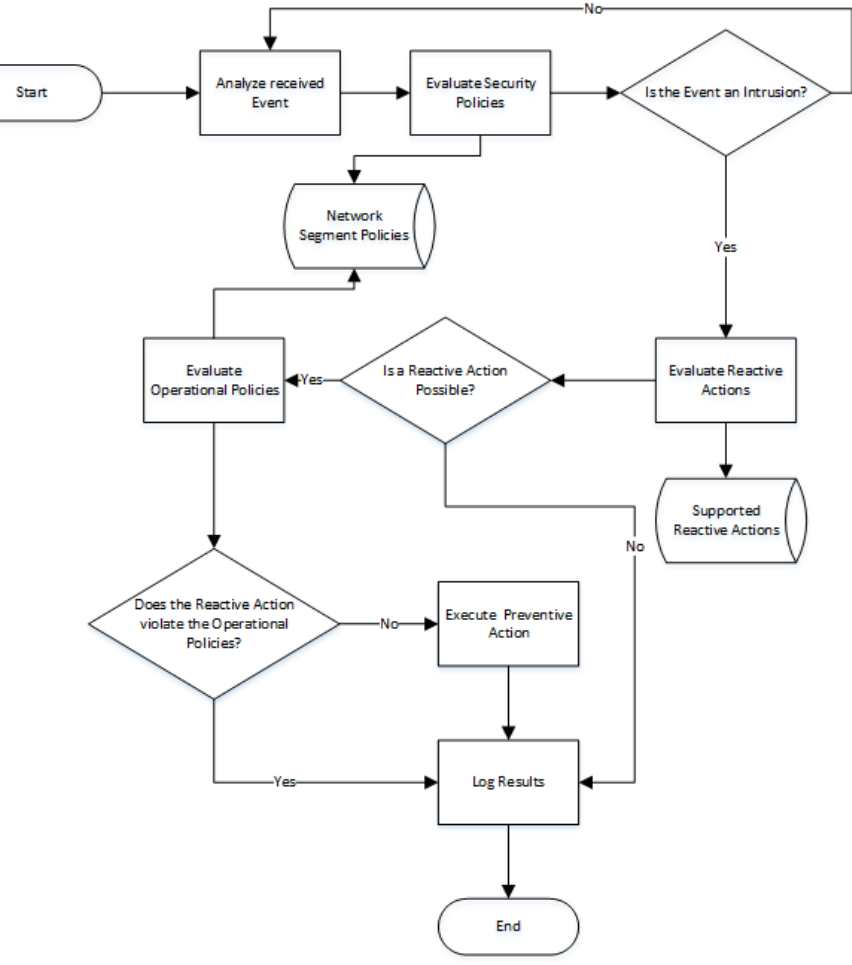
Figure 3. Information flow of the presented concept for reactive